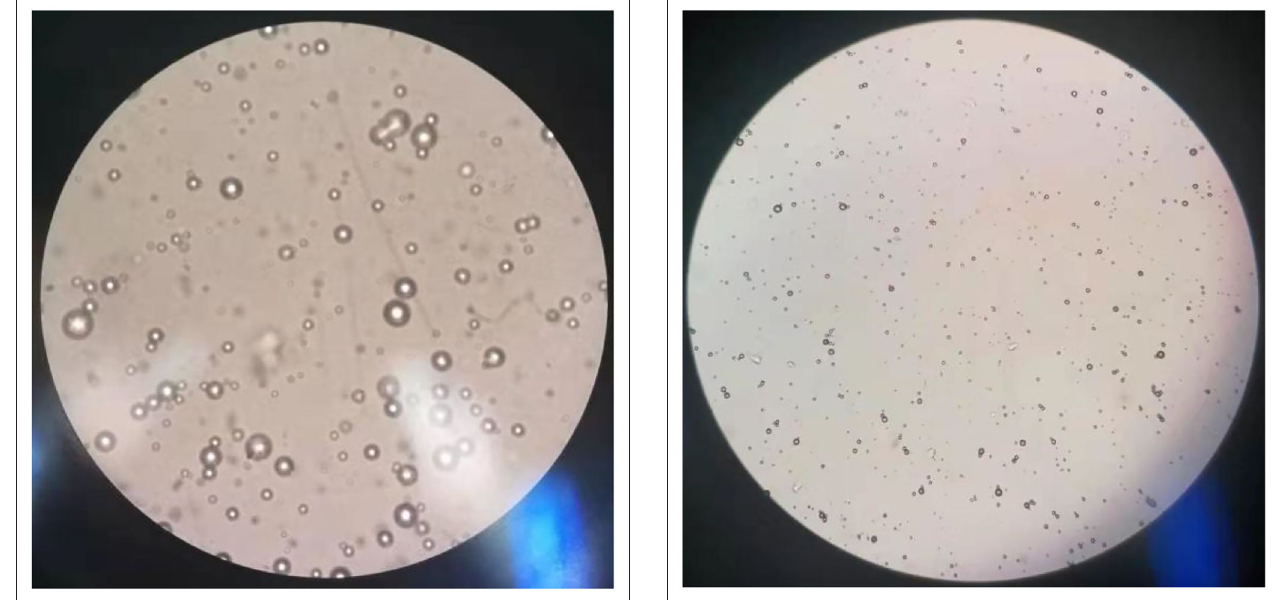
22.946 µ m, δ = 1.453; particle size. Distribution diagrams